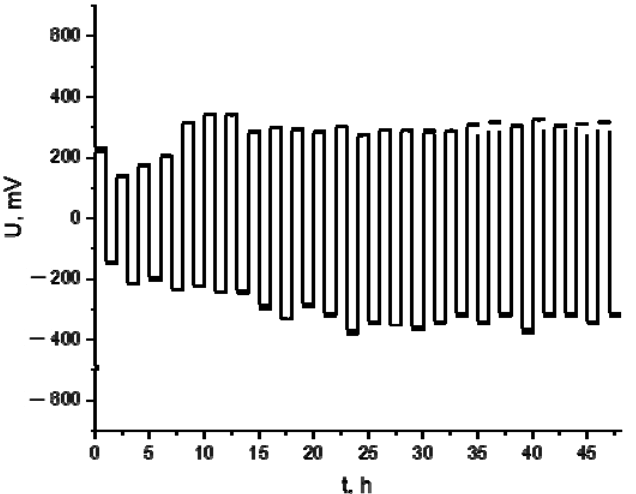
Figure 7. Galvanostatic cycling data of the Li-In (90 at% Li) | LLZcomp | Li-In (90 at% Li) cell with applied current of ±8 mA at 200 °C.